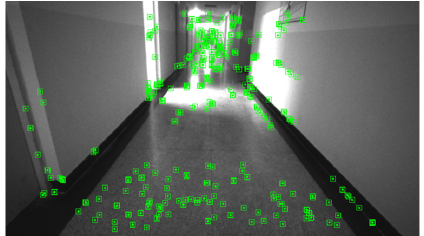
Figure 13. Building environment point feature extraction.